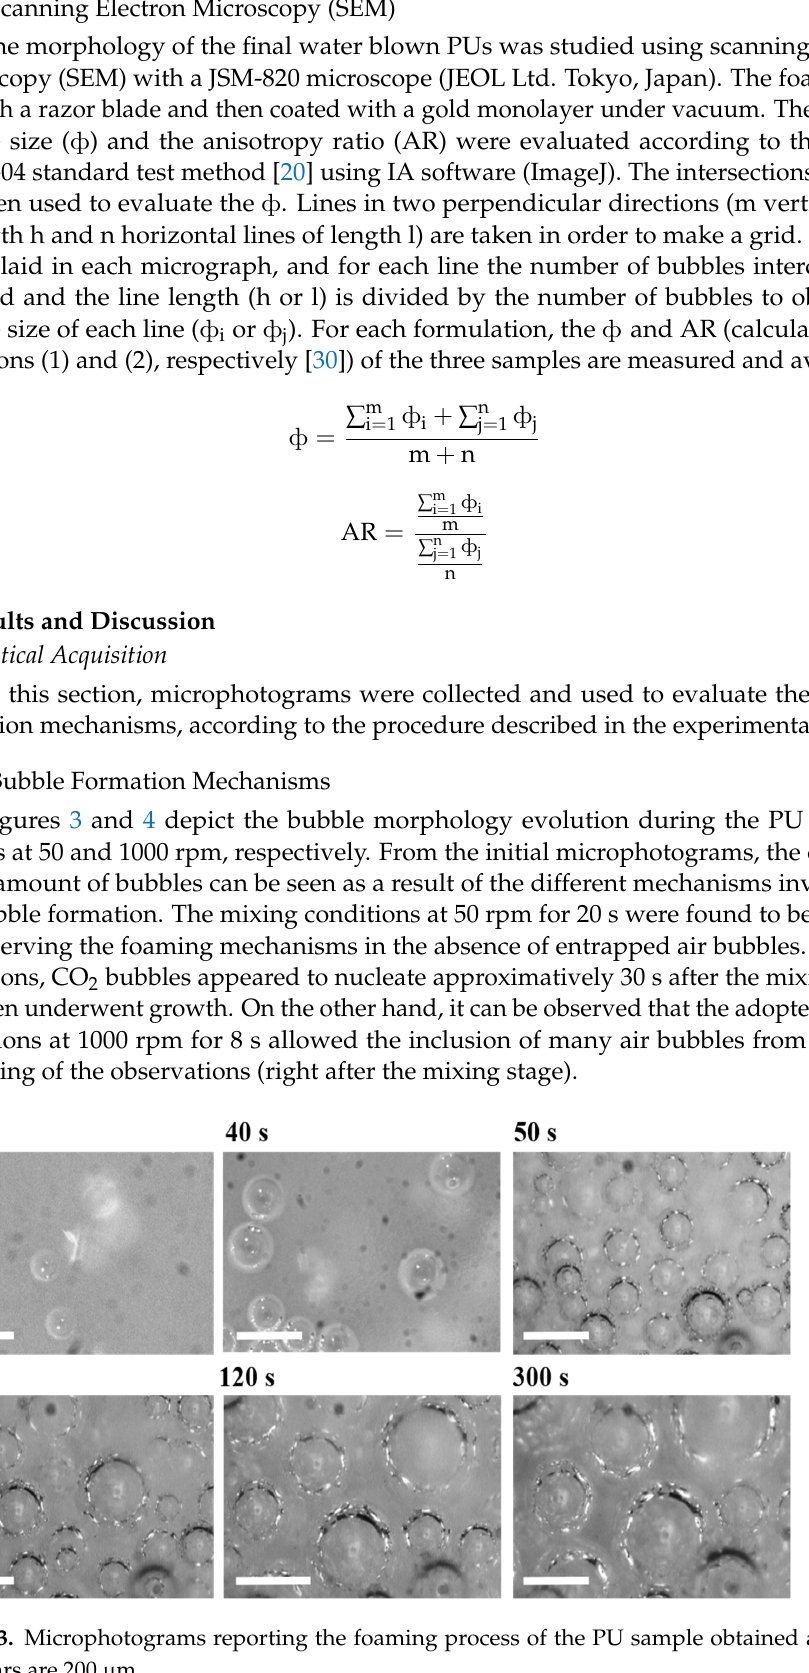
Figure 4. Microphotograms reporting the foaming process of the PU sample obtained at 1000 rpm. Scale bars are 200 µm. The foaming behavior at the several investigated mixing speeds is reported in terms of the bubble density (N) (standard deviation ranged approximatively from 4×10 3